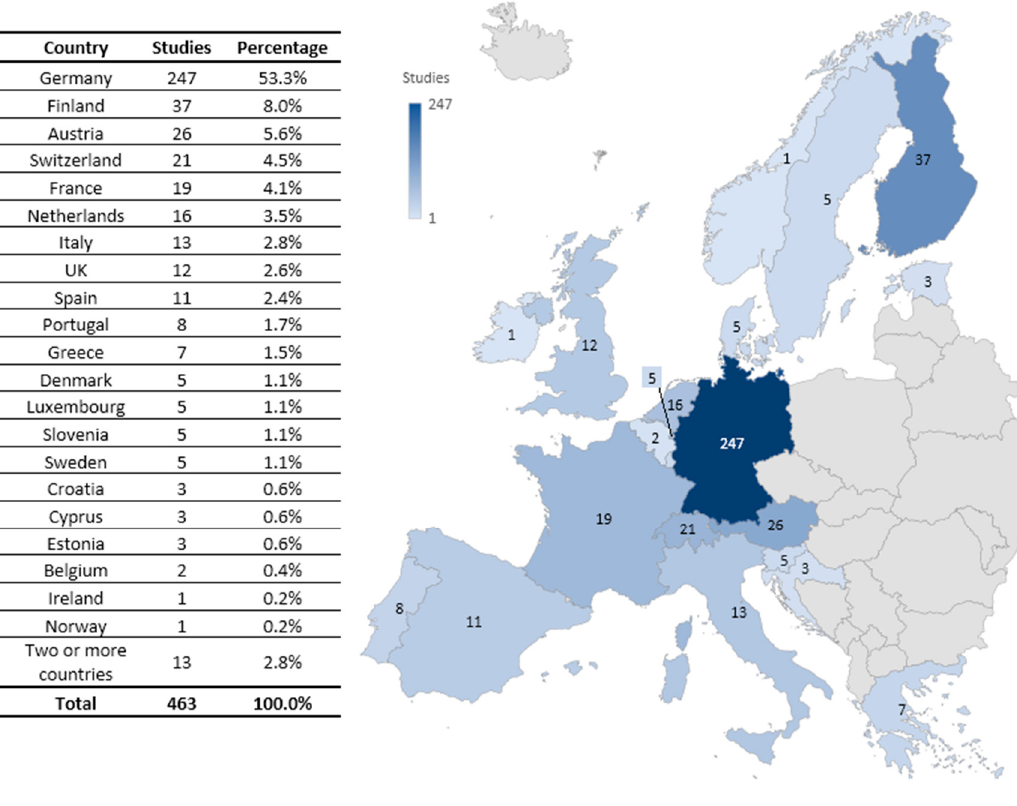
Figure 4. Total uses of standardized questionnaires in